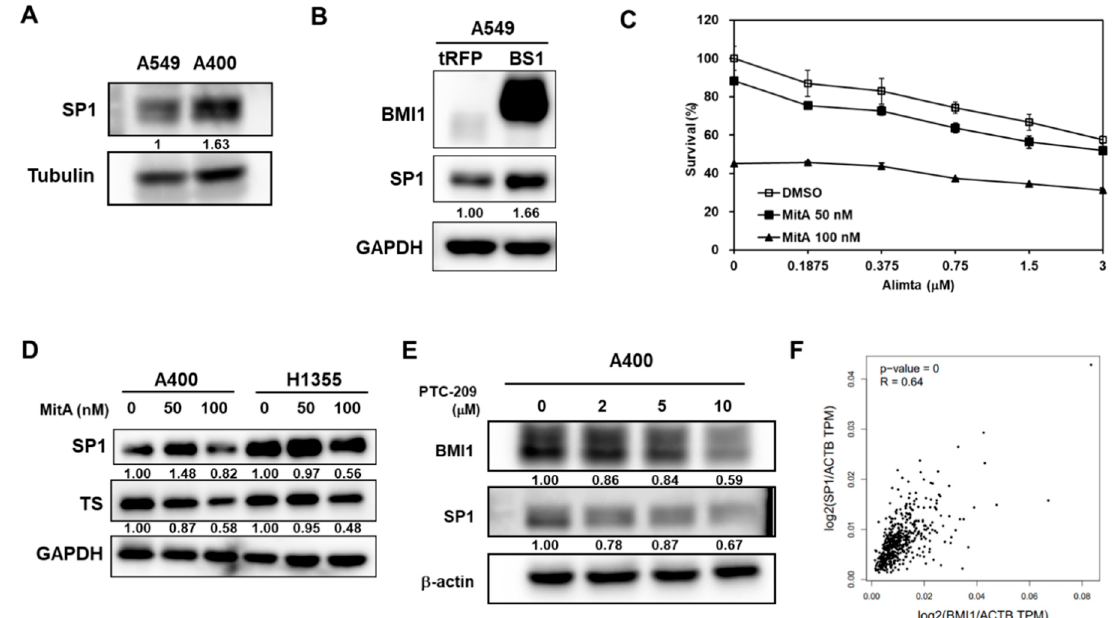
Figure 5. BMI1 is an upstream signaling molecule of SP1 protein expression in pemetrexed-resistant NSCLC cells. ( A ) SP1 expression in A549 or A400 cells was determined by western blot. ( B ) BMI1 and SP1 expression in tRFP- or BMI1-overexpressed A549 (BS1) were determined by western blot. ( C ) Mithramycin A (MitA), the SP1 inhibitor, was used to treat A400 cells at 50 or 100 nM with co-treatment of pemetrexed at the indicated concentration. DMSO was used as a negative control. The cell survival was determined by MTT assay. ( D ) A400 or H1355 cells were treated with the indicated concentration of MitA for 48 h. The protein expression of SP1 or BMI1 was then determined by western blot. ( E ) A400 cells were treated with the indicated concentration of PTC-209 for 48 h and the protein expressions of BMI1 or SP1 were determined by western blot. ( F ) The correlation between mRNA of SP1 and BMI1 among lung adenocarcinoma patients of the Cancer Genome Atlas (TCGA) database was analyzed by the Genen Expression Profiling Interactive Analysis webtool (GEPIA) website. The experiments of ( A ) to ( E ) were done three times and data from one experiment were